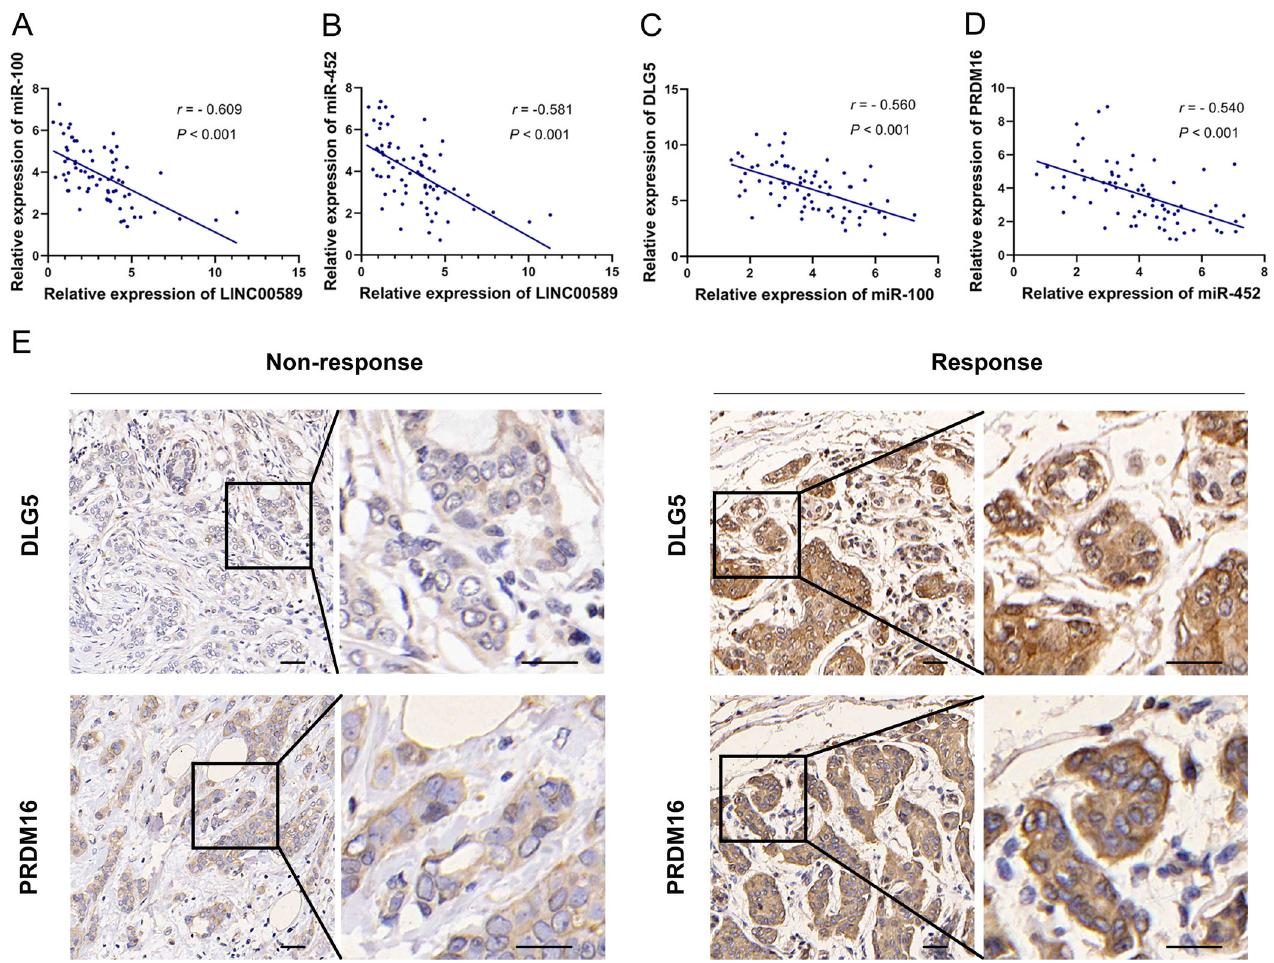
Fig. 9 LINC00589 -dominated regulatory networks in breast cancer patients ’ tissues. A – D mRNA expression of LINC00589 , miR-100 , miR-452 , DLG5 , and PRDM16 of the dissected tissues from 71 patients were measured by qRT-PCR assay. The correlation of LINC00589 - miR-100 ( A ), LINC00589 - miR-452 ( B ), miR-100 - DLG5 ( C ), and miR-452 - PRDM16 ( D ) were analyzed by the Spearman correlation test. E Protein expression of DLG5 and PRDM16 were analyzed by immunohistochemistry (IHC) in tissues from trastuzumab-responding or non-responding patients. Scale bar 50 μ